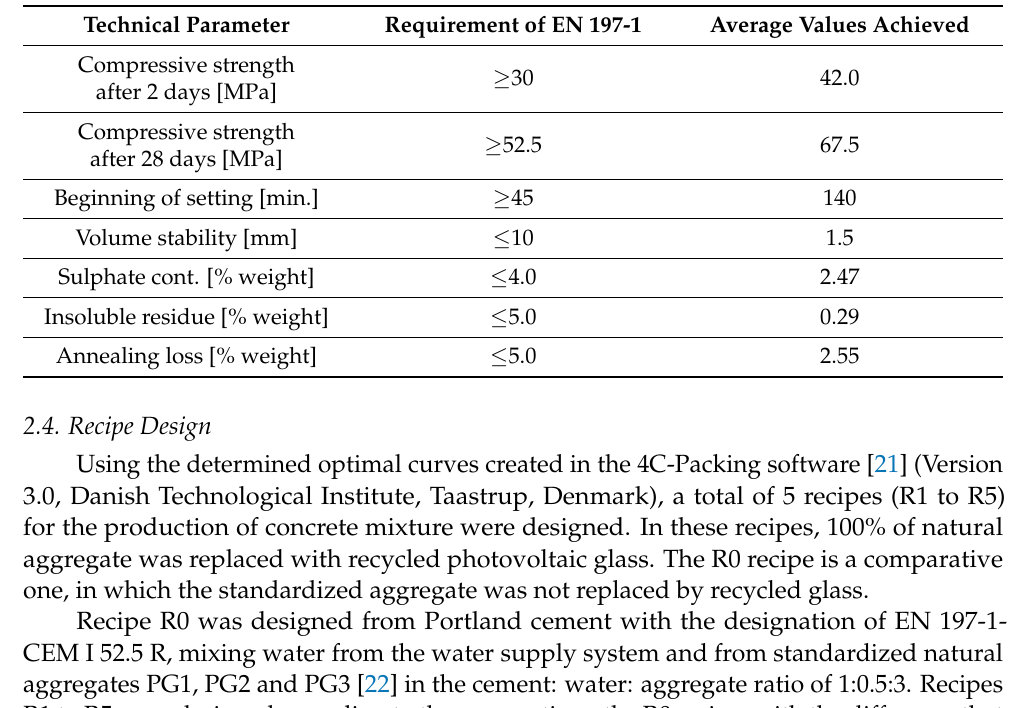
Table 2. Portland cement properties CEM I 52.5 R [19].